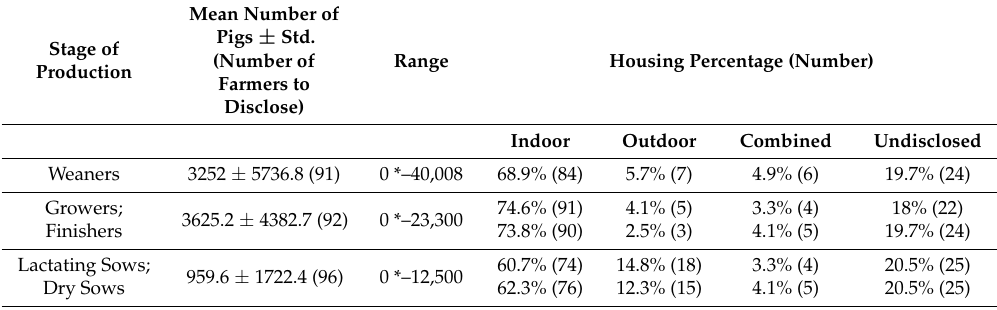
Table 2. Mean number of pigs per farm at any moment in time and housing system for weaners, grower/finishers, lactating and dry